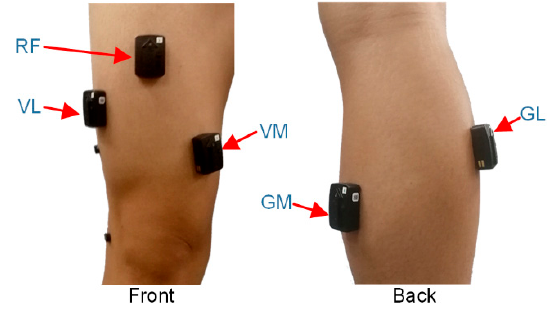
Figure 1. The locations of surface electromyography (sEMG) sensors.